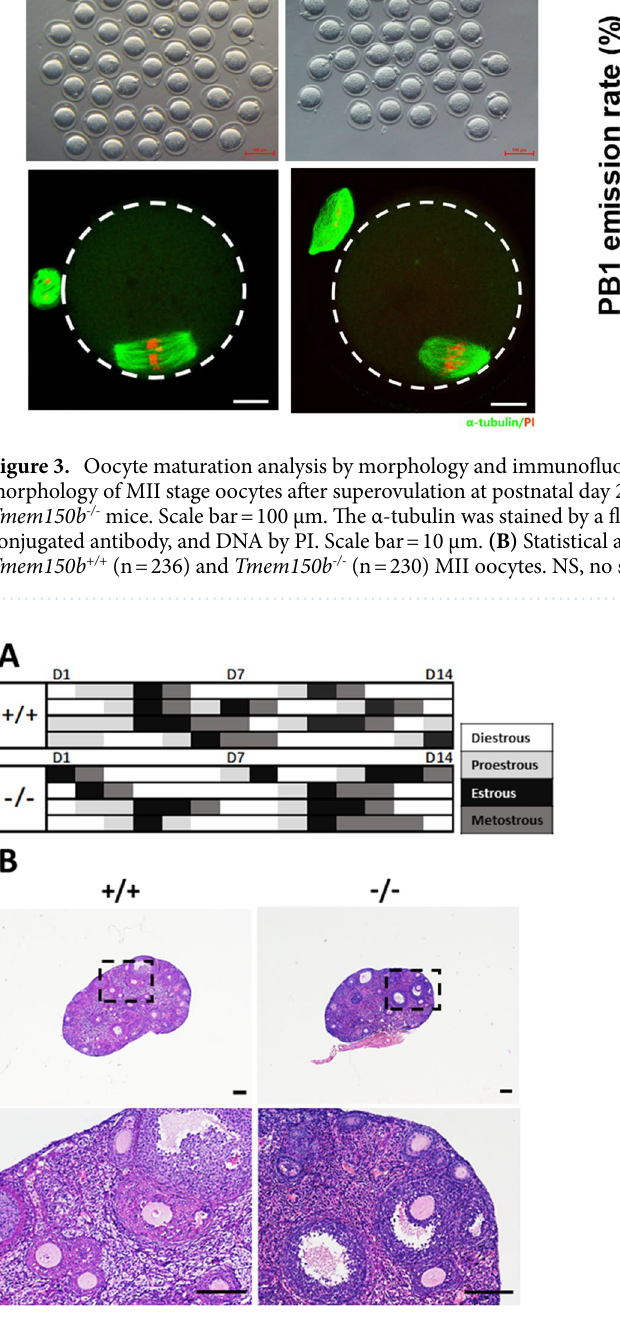
Figure 4. Estrous cycle analysis of female mice and morphology analysis of ovaries by H&E staining. (A) Regular estrous cycle of 2-month-old female mice from both genotypes. (B) Ovarian histological analysis of 3-month-old Tmem150b + / + and Tmem150b -/- females by H&E staining. Scale bar = 100